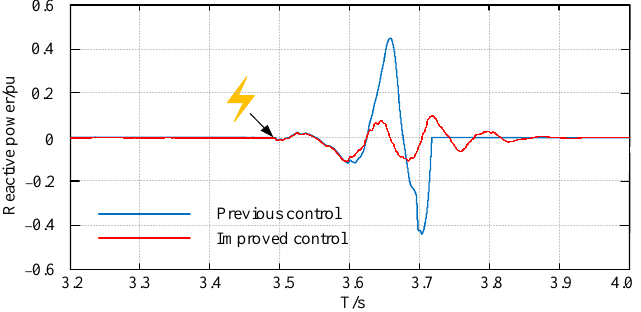
Figure 13. The reactive power of the Hornsea 1B.